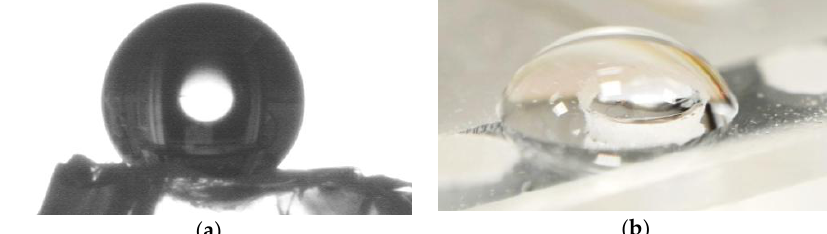
Figure 5. ( a ) Water droplet on the surface of a silica aerogel block. The contact angle is 136°; ( b ) Water droplet on one of the holes containing the aerogel. The water does not flow through the hole with the gel despite its high porosity of 85% in contrast to a second setup without